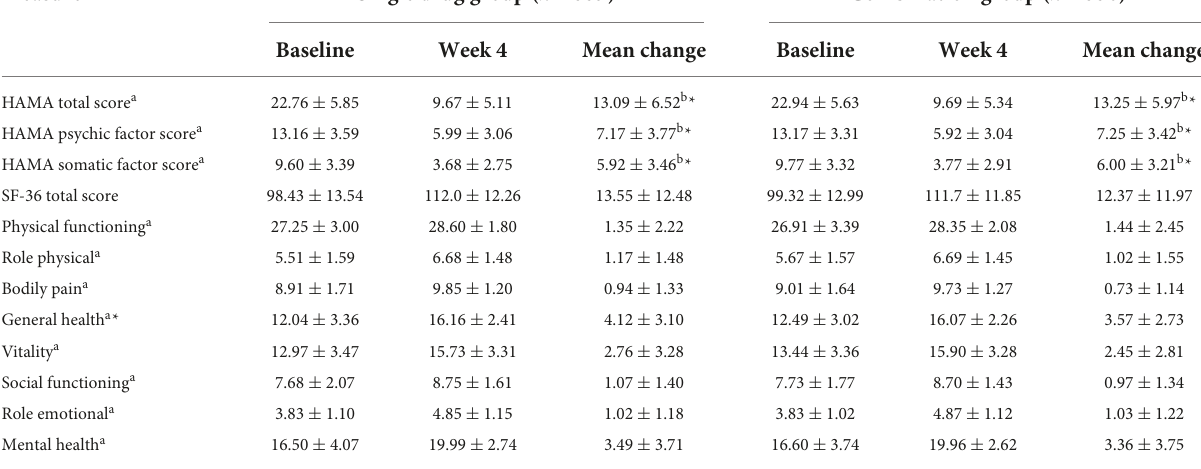
TABLE 3 Comparison of HAMA and SF-36 health survey scores at baseline and at 4 weeks post-treatment between patients with generalized anxiety disorder treated with Jiuwei Zhenxin granules alone (single drug group) or in combination with alprazolam (combination group). Measure